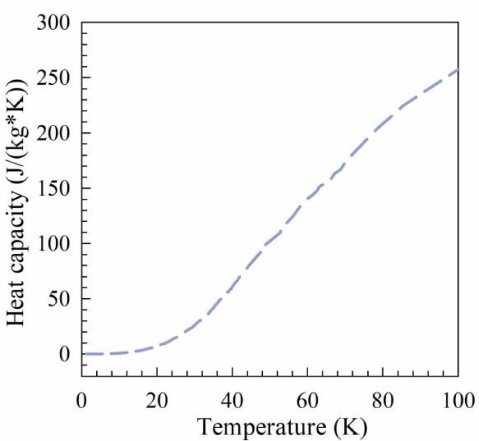
Figure 9. Temperature-dependent heat capacity of copper.